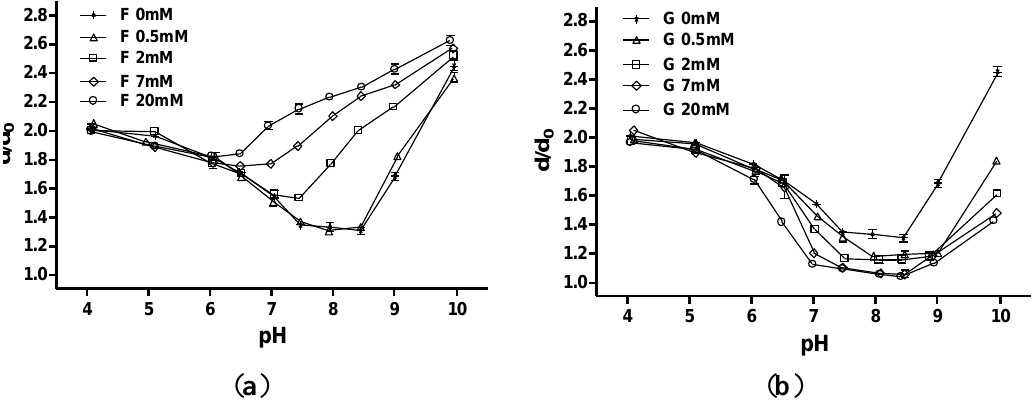
Figure 5. Equilibrium swelling of DMP-co-MPBA-co-AAm hydrogels in buffer solution at different fructose ( a ); or glucose ( b ); concentrations ( n =